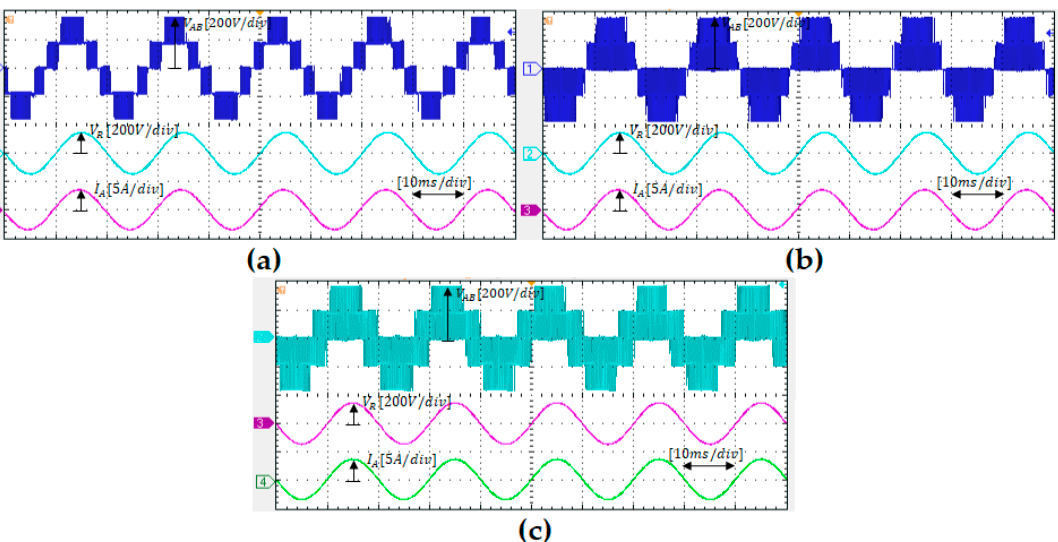
Figure 13. Experimental results of output line–line voltage ( V AB ), load voltage ( V RA ), and output phase current ( I A ). ( a ) Method 1, ( b ) method 2, ( c ) proposed method.